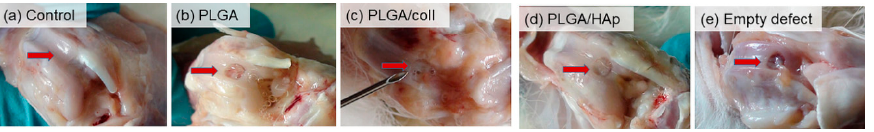
Figure 3. Rabbit femoral trochlear of control knee ( a ) and four weeks post-surgery when defect was filled with PLGA sca ff old ( b ), PLGA / coll sca ff old ( c ), PLGA / HAp ( d ), and when the defect was left empty ( e ). Arrows show trochlear groove ( a ), defects filled with sca ff olds ( b – d ), and empty defect ( e